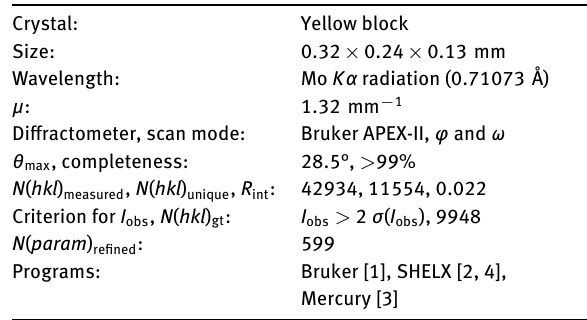
Table 1: Data collection and